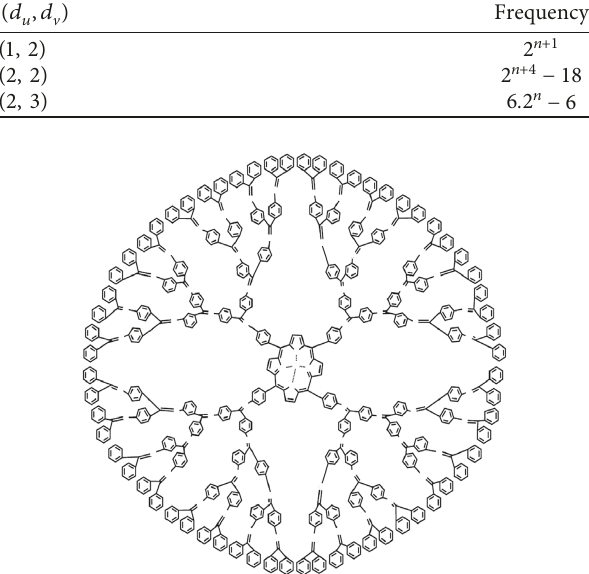
P n n . P n n , of end vertices of